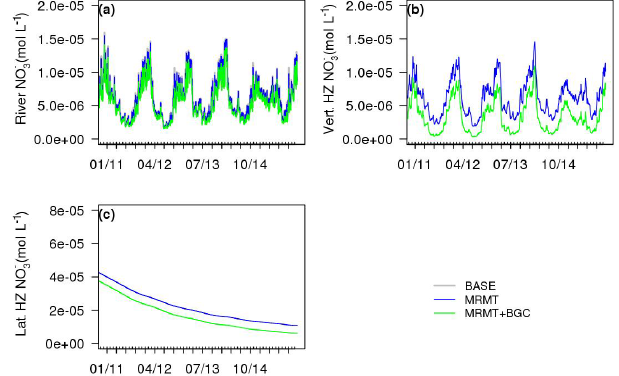
Figure 4. Comparison of nitrate in the river (a) , vertical HZ (b) , and lateral HZ (c) between cases BASE, MRMT, and MRMT+BGC at reach